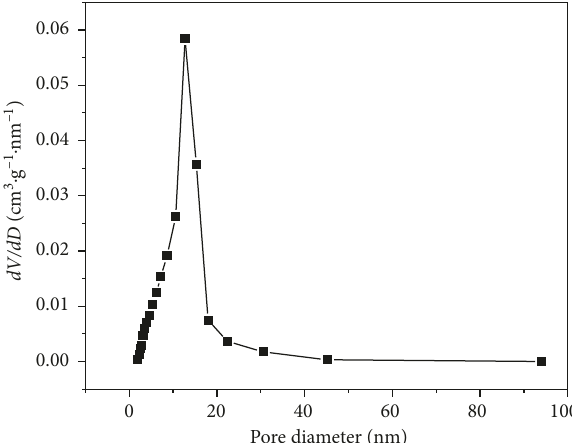
Figure 5: Pore diameter distributions of